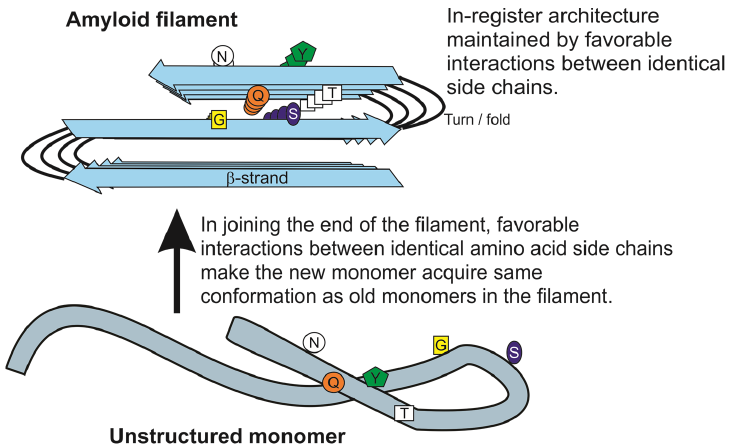
Figure 1. The in-register parallel folded beta-sheet architecture of yeast prion amyloids can explain their ability to template their conformation. H-bonds and hydrophobic interactions of identical amino acid side chains force adjacent molecules in the parallel beta-sheet to stay in-register and provide the fundamental force driving prions to template their conformation. A new monomer joining the end of the filament adopts a turn at the same place in the peptide chain as the molecules of that protein already in the filament in order to have those favorable side chain–side chain interactions. This is for prions what “Watson–Crick base pairing” is for DNA. The single letter amino acid code is used. Adapted from [34]. Not subject to U.S. Copyright. The [Het-s] prion of the filamentous Podospora anserina was the first prion recognized to be responsible for a normal function, namely heterokaryon incompatibility, a fungal recognition of self/non-self [35]. Interestingly, the [Het-s] amyloid has a different architec- ture, namely, a two turns/molecule beta-helix and there is only one variant of [Het-s] (ex- plained in refs. [36,37]). There was then an apparent strong desire among many to declare other prions to be advantageous, although the evidence was not always convincing. Find-